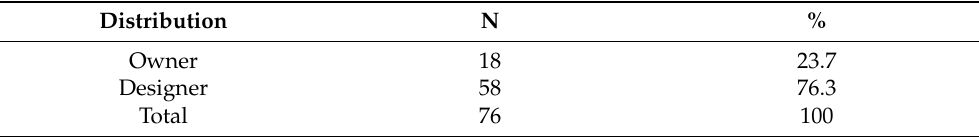
Table 4. Distribution of survey